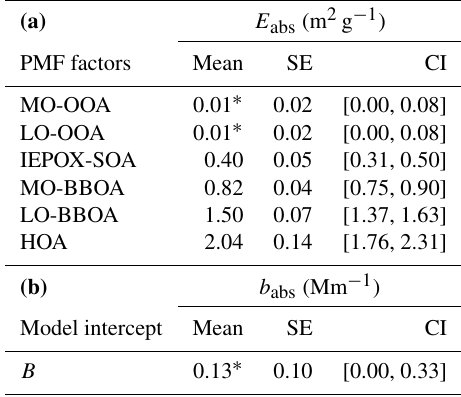
Table 3. Results of the constrained linear least-squares regression analysis for the BrC absorption coefficient (Eq. 5). (a) Mass absorp- tion efficiency E abs associated with each PMF factor. (b) Model intercept. The mean, standard error (SE), and 95% confidence in- terval (CI) are listed in each panel. They were obtained through bootstrap of the regression analysis considering different samples (i.e., sets of points in time) for 10 4 runs. Unit of Mm − 1 represents 10 − 6 m − 1 . The coefficient of determination R 2 between predicted b abs , BrC , pred and observed b abs , BrC was 0.66. The symbol “ ∗ ” indi- cates that the estimated value was statistically not higher than zero at the significance level of